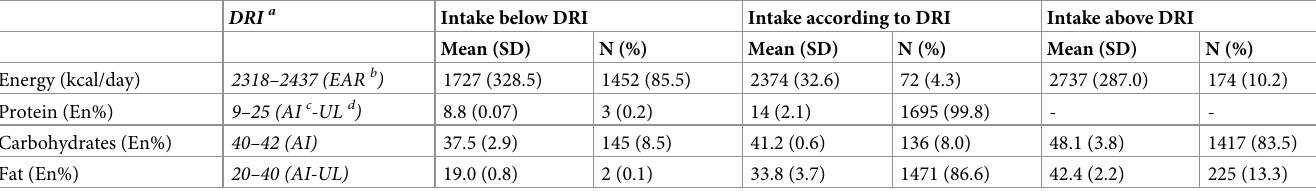
Table 2. Number of female participants meeting dietary reference intake for macronutrients (protein, carbohydrates and fat) and